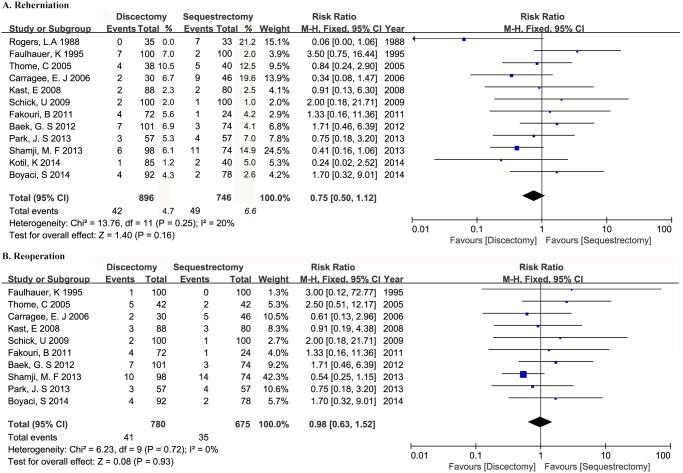
Forest plot illustrating reherinaiton rate (A) and reoperation rate (B) of meta-analysis comparing discectomy with sequestrectomy.